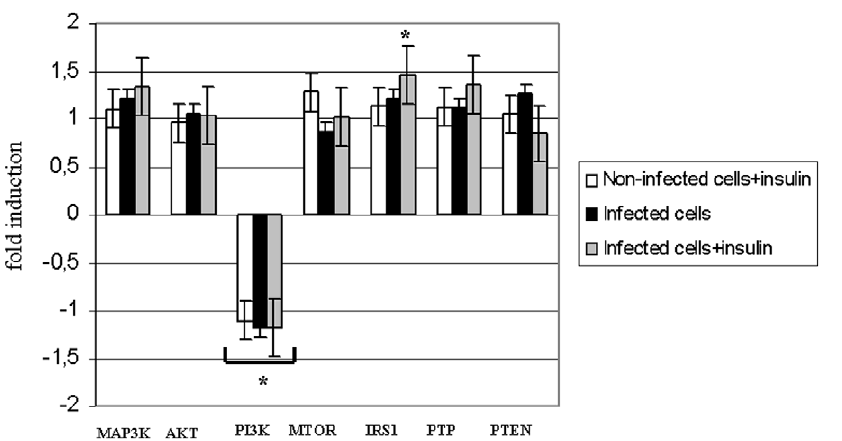
Figure 1. Insulin effect on gene expression in vitro. Relative gene expression (fold induction [ + ] and fold inhibition [ 2 ]) in Huh7.5 cells grown in the presence of insulin (10 nM) and JFH-1 particles (one particle per cell). Experiments were performed in triplicate. Control experiment (non- infected cells and no insulin added) was used as a reference (fold induction=1). (*)=p , 0.05.